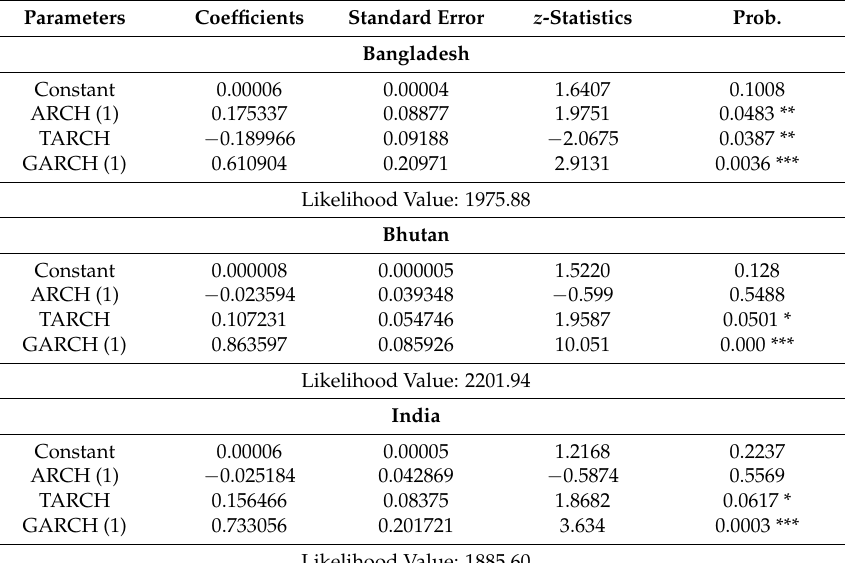
Table A5. Estimation of Parameters in TGARCH (1,1) Model for Exchange Rate Volatility.